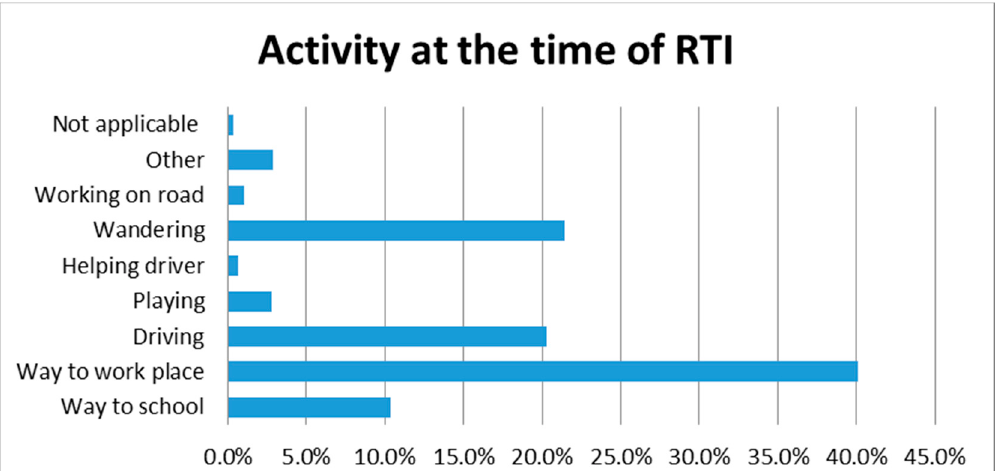
Figure 3. Activity at the time of RTI (both mortality and morbidity).